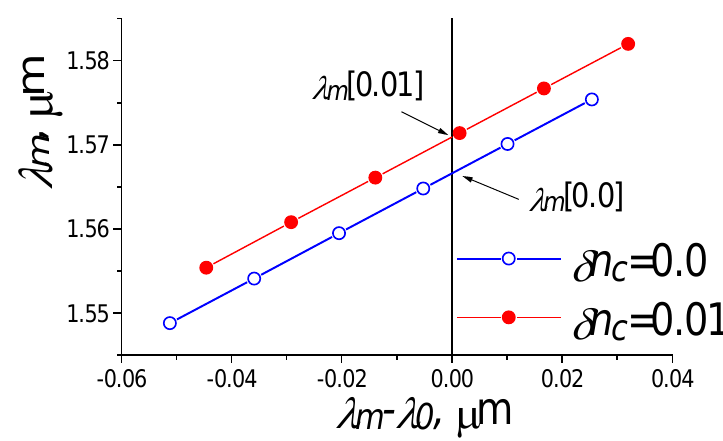
Figure 7. Dispersion compensation algorithm for two-dimensional simulation by FDTD method using effective index method (EIM).